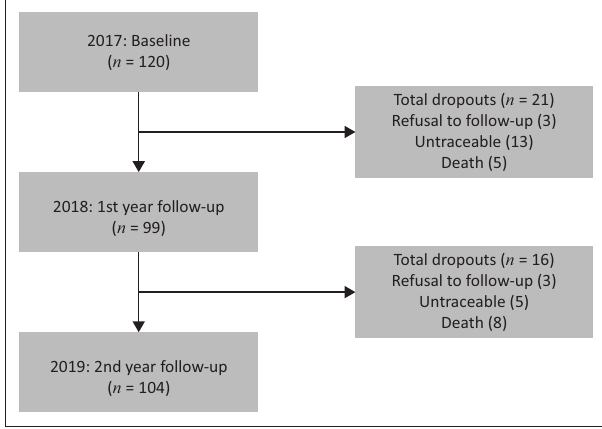
FIGURE 1: Participant flowchart and reasons for loss to